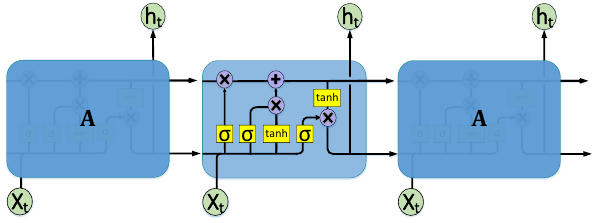
Figure 1. The repeating module in an LSTM containing four interacting